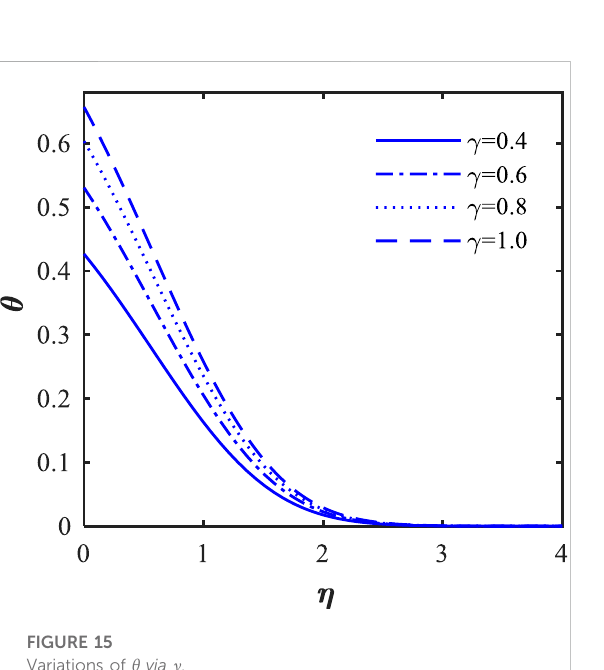
FIGURE 14 Variations of ϕ via K 1 .